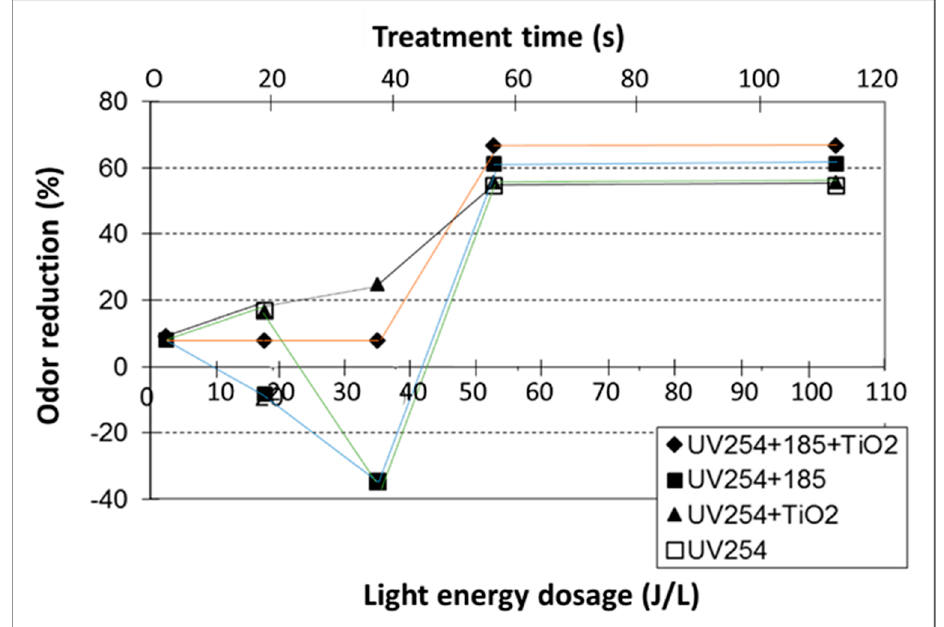
Figure 4. Total odor reduction (expressed as odor detection thresholds (ODT)) as a function of measured UV energy dosage at 254 nm (obtained at different treatment time). The ODT of each air sample was assessed by at least 4 trained panelists using a forced-choice dynamic-dilution olfactometer at Iowa State University.